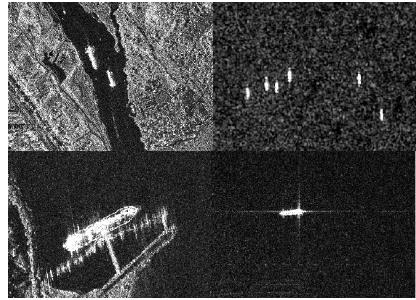
Figure 3. Sample images from the SAR ship detection dataset (SSDD) dataset [7].